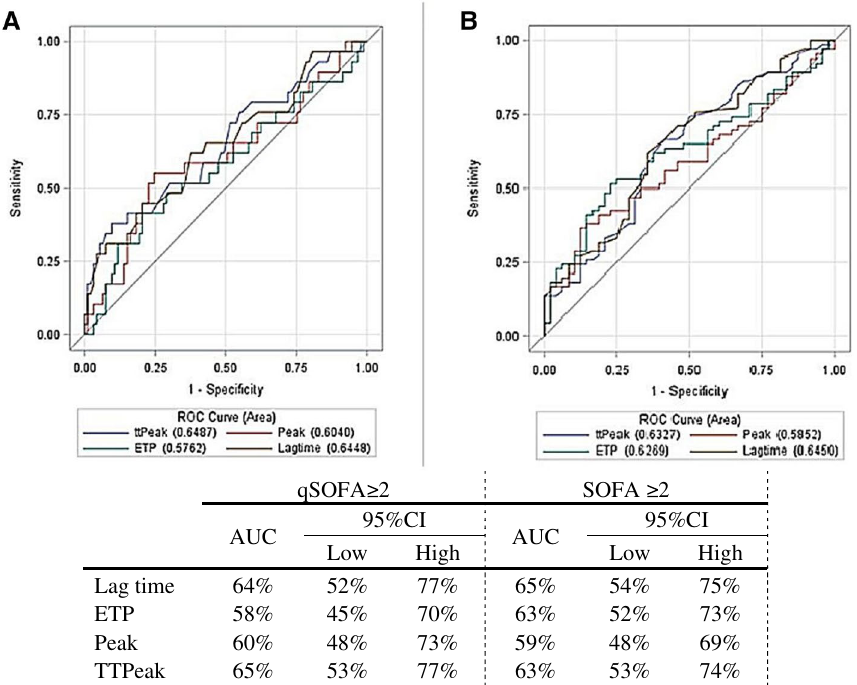
Figure 2. ROC curves in predicting high levels of qSOFA and SOFA. ( A ) represent the thrombin generation parameters in predicting high level of qSOFA (2–3 scores); ( B ) represent the thrombin generation parameters in predicting high level of SOFA (2 + scores). ROC receiver operating characteristic. ETP endogenous thrombin potential. ttPeak time to peak. SOFA sequential organ failure assessment. qSOFA quick